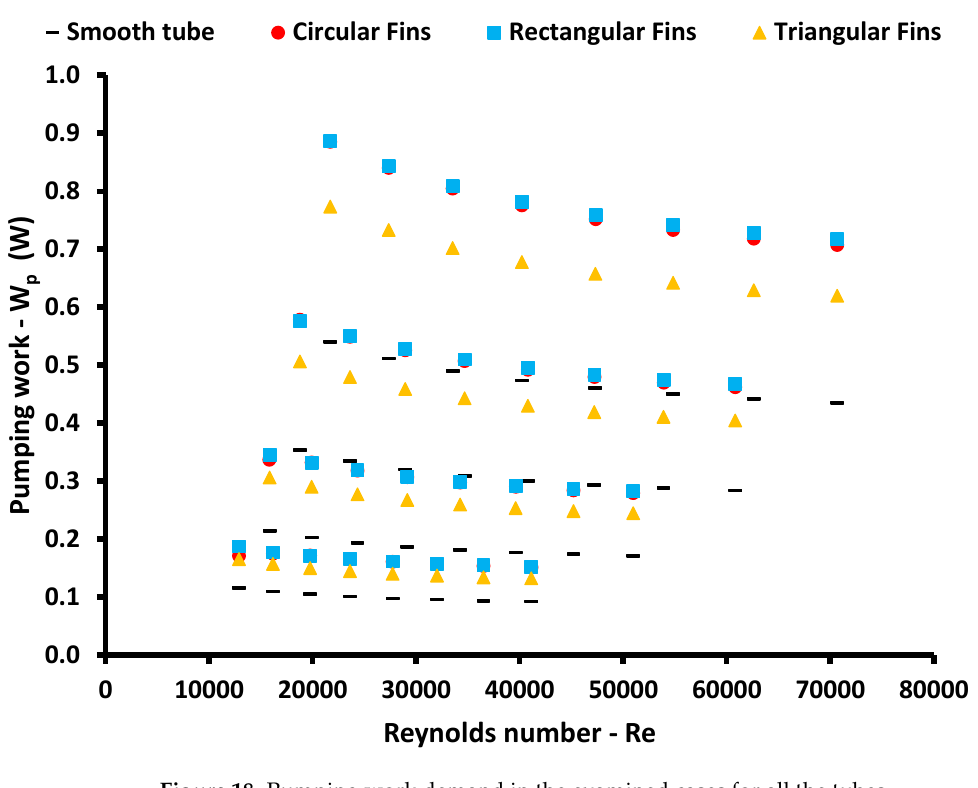
Figure 18. Pumping work demand in the examined cases for all the tubes.